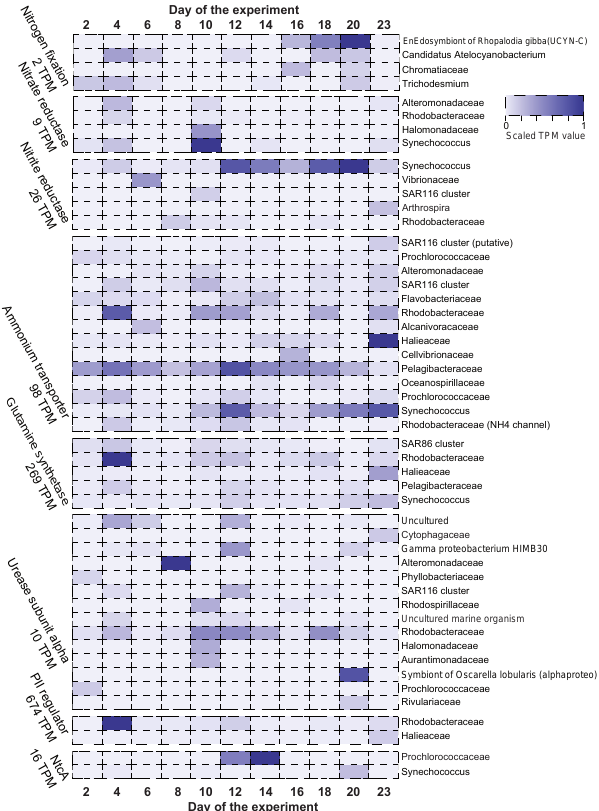
Figure 6. Expression of selected genes indicative for different nitro- gen acquisition strategies. TPM counts were summed per taxonomic family, the names of which are denoted to the right of each line. The maximum TPM value for each group is written below the name of that group. For plotting, values were scaled within each functional group, but not for each line, resulting in the maximum color density always representing the maximum TPM. After the name, in brack- ets, is additional annotation information, if deviant from the name of the functional group. The nifHDK transcript counts were sum- marized for each taxon to avoid possible classification biases due to multicistronic transcripts (i.e., a multicistronic transcript might be classified as either of these depending on the best BLAST